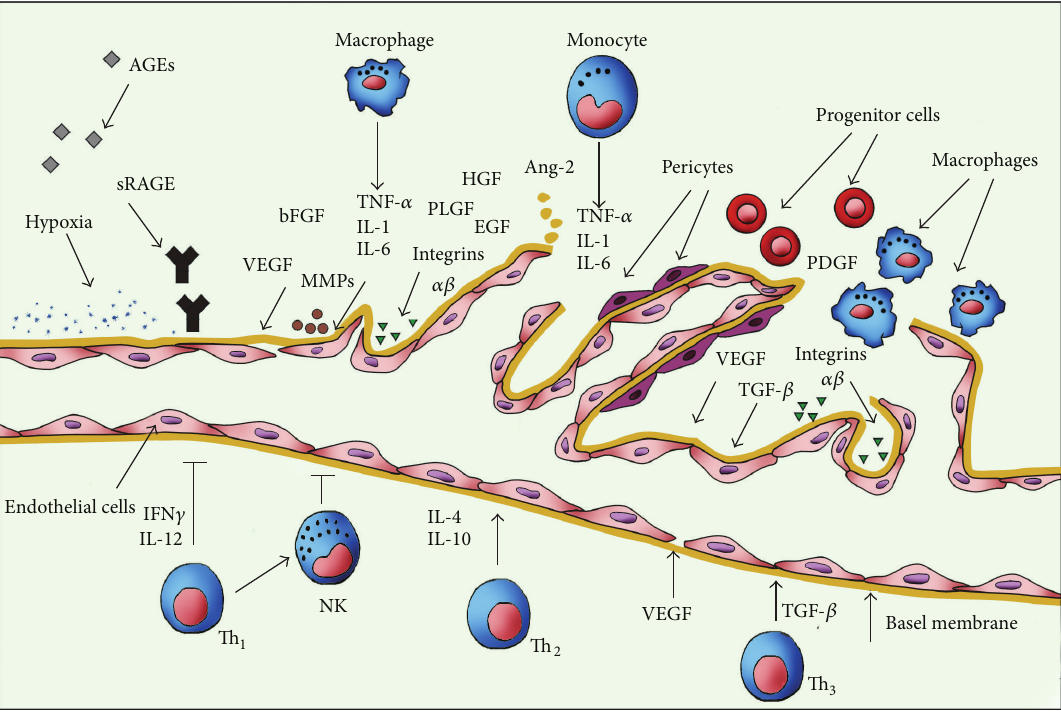
Figure 1: Biomarkers involved in the development and progression of diabetic retinopathy. AGEs—advanced glycation end products, RAGEs—receptor for advanced glycation end products, bFGF—basic fibroblast growth factor, VEGF—vascular endothelial growth factor, MMPs—metalloproteinases, TNF- 𝛼 —tumor necrosis factor alpha, IL1—Interleukin 1, Interleukin 6—IL6, HGF—hepatocyte growth factor, PLGF—placental growth factor, EGF—epidermal growth factor, Ang-2—angiopoietin-2, PDGF—platelet-derived growth factor, TGF- 𝛽 - transforming growth factor-beta, Th—helper lymphocytes, NK—natural killer, IL4—Interleukin 4, IL10—Interleukin 10,